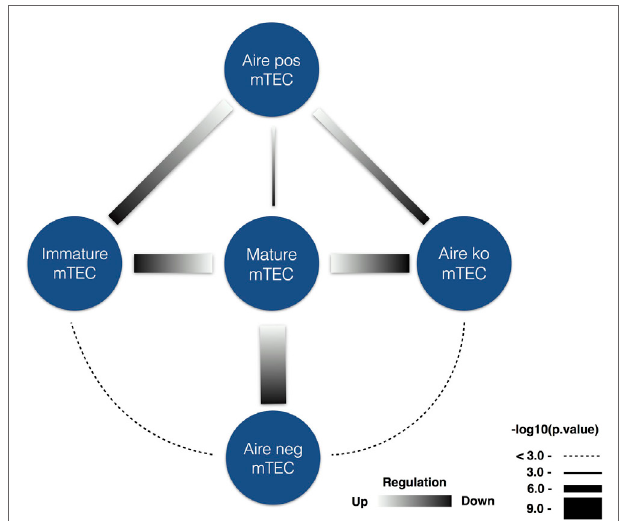
FigUre 7 | Medullary thymic epithelial cells (mTEC) specific expression of tissue-restricted (TR) APECED autoantigens. TR APECED autoantigens but not the non-tissue-restricted (NTR) autoantigens were upregulated in mature Aire-expressing mTECs. Datalists [generated by Sansom et al. (42)] of differentially expressed genes in mTEC subsets were compared to the list of APECED autoantigens. Strong enrichment of TR autoantigens was found among differentially upregulated genes in mature mTEC subpopulation in comparison to (i) immature mTECs, (ii) Aire-negative mTECs, and (iii) Aire-knockout mTEC populations. Blue circles mark the corresponding cell populations, the gradient in connecting lines indicate whether the genes in comparison were up- or downregulated, and the width of the lines represents the logarithmized p -value. No significant overlap was found among NTR autoantigens differentially expressed in any of the studied thymic cell